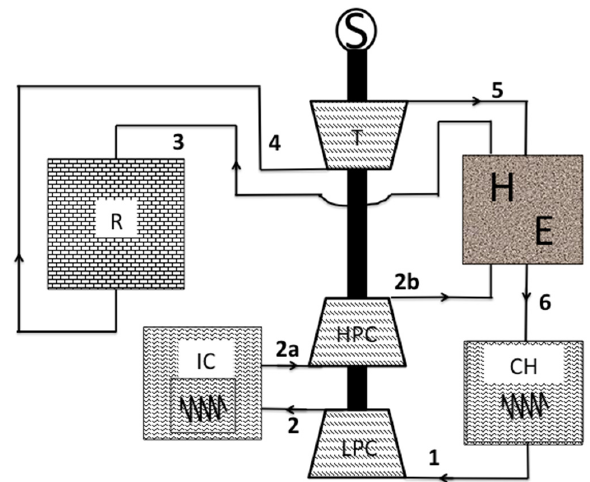
Figure 2. Typical Intercooled Cycle Recuperated (ICR) [8]. Single shaft spool connection to the turbomachinery, which includes an Low Pressure Compressor (LPC), High Pressure Compressor (HPC), and turbine as part of the turbomachinery, precooler, intercooler, reactor, and recuperator. The schematic shows 8 stations (station 2 comprising 3 stations).